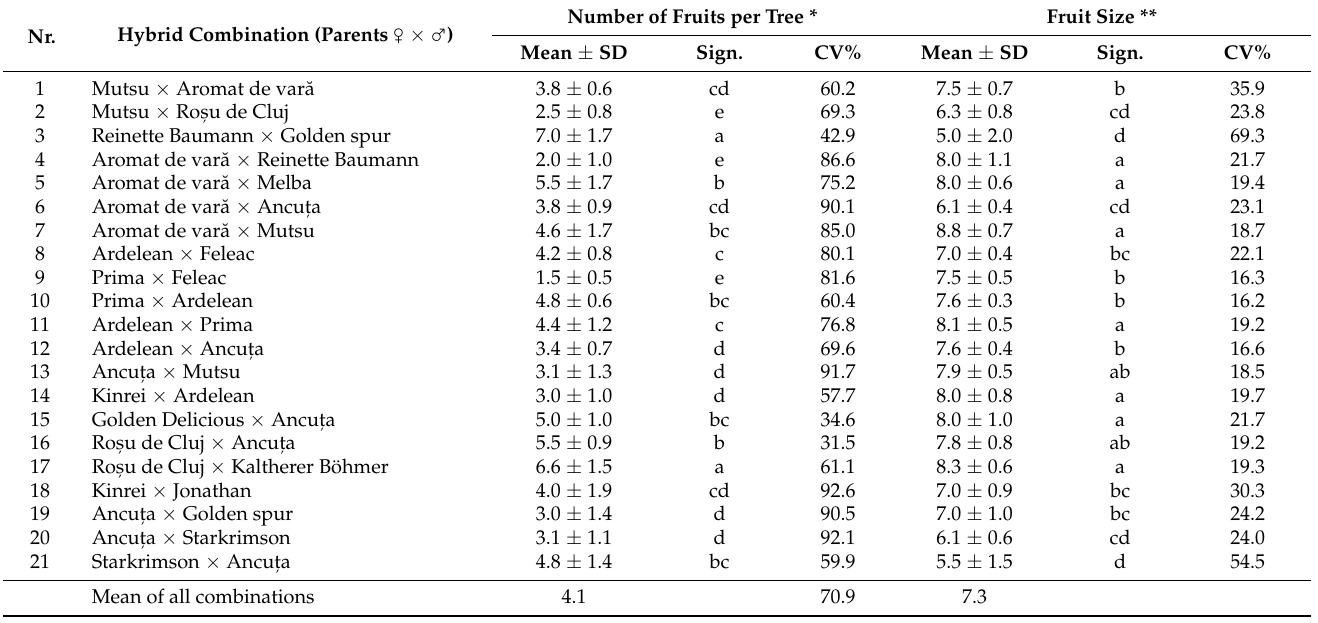
Table 4. Number of fruits per tree and fruit size in F 1 apple hybrids in different combinations of hybrids according to